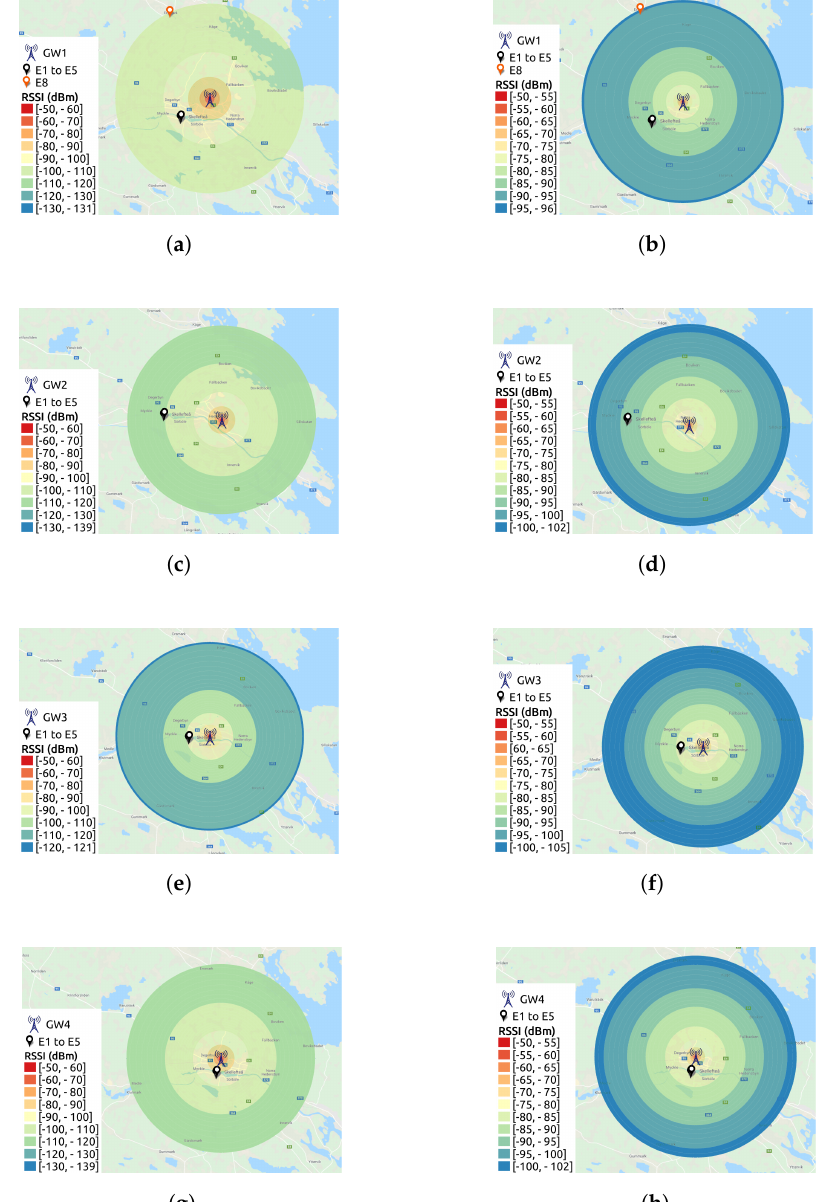
Figure 2. RSSI coverage graphs by CloudRF [7], where the city of Skellefteå is in the center of the coverage circles. The map layer is from Google Maps [41]. ( a ) GW1—Okumura-Hata. ( b ) GW1—ITM. ( c ) GW2— Okumura-Hata. ( d ) GW2—ITM. ( e ) GW3—Okumura-Hata. ( f ) GW3—ITM. ( g )